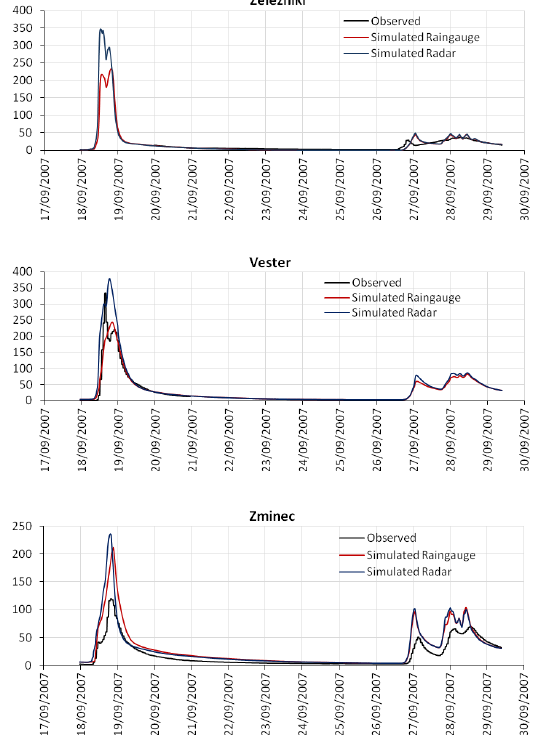
Fig. 6a. Model results for the flash flood period of 18 September Figure 6a: Model results for the flash flood period of September 18 th 2007 using interpolated 5 2007 using interpolated raingauge precipitation. raingauge precipitation. 6